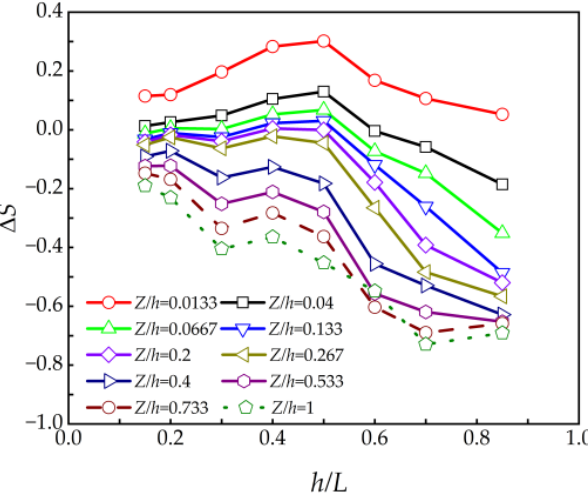
trend of the speedup ratio at each position along the windward and leeward sides of the hill is studied by selecting the near-ground position ( Z/h = 0.0133) to provide a basis for building the speedup ratio model for hilly terrain.